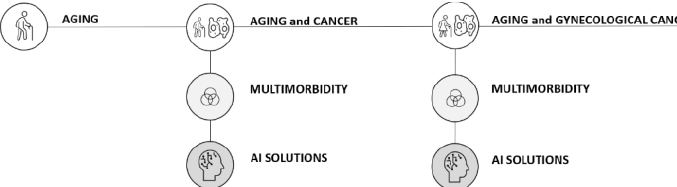
Figure 2. Visual representation of the literature. AGING: [16,17,27,28]. AGING and CANCER: [16–18,26,29]; MULTIMORBIDITY: [15,27,30– 41]; AI SOLUTIONS: [20,21,42– 48]. AGING and GYNECOLOGICAL CANCER: [13,49–